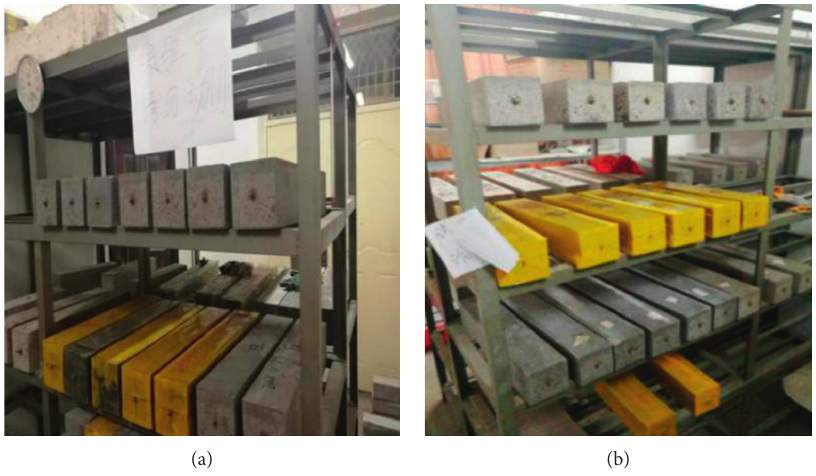
Figure 2: Positioning of concrete test specimens during